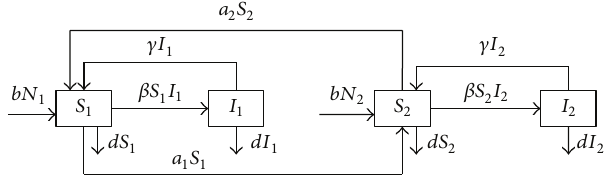
Figure 1: The transfer diagram of SIS model with population mi-